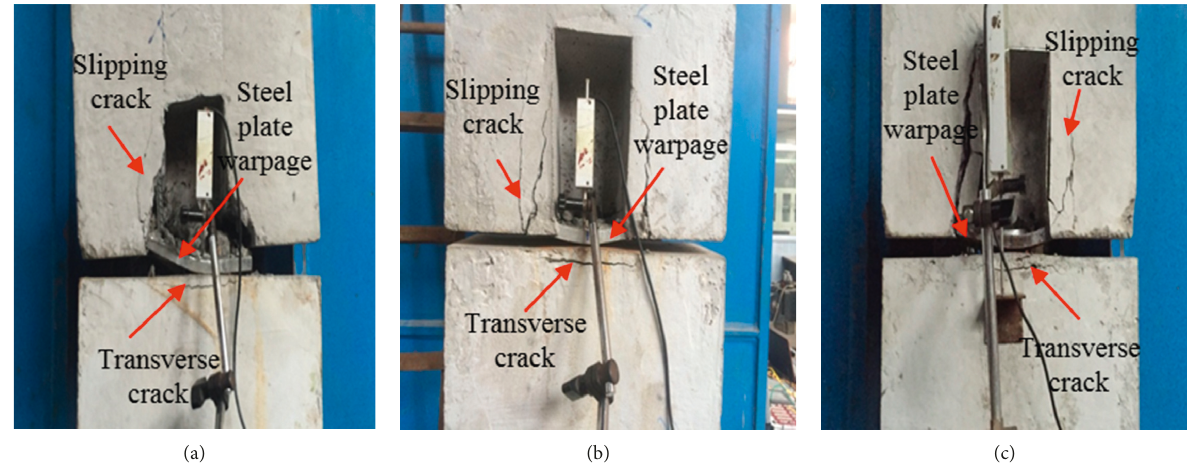
Figure 6: Failure modes of the specimens during the tensile test: (a) T1, (b) T2, and (c) T3.